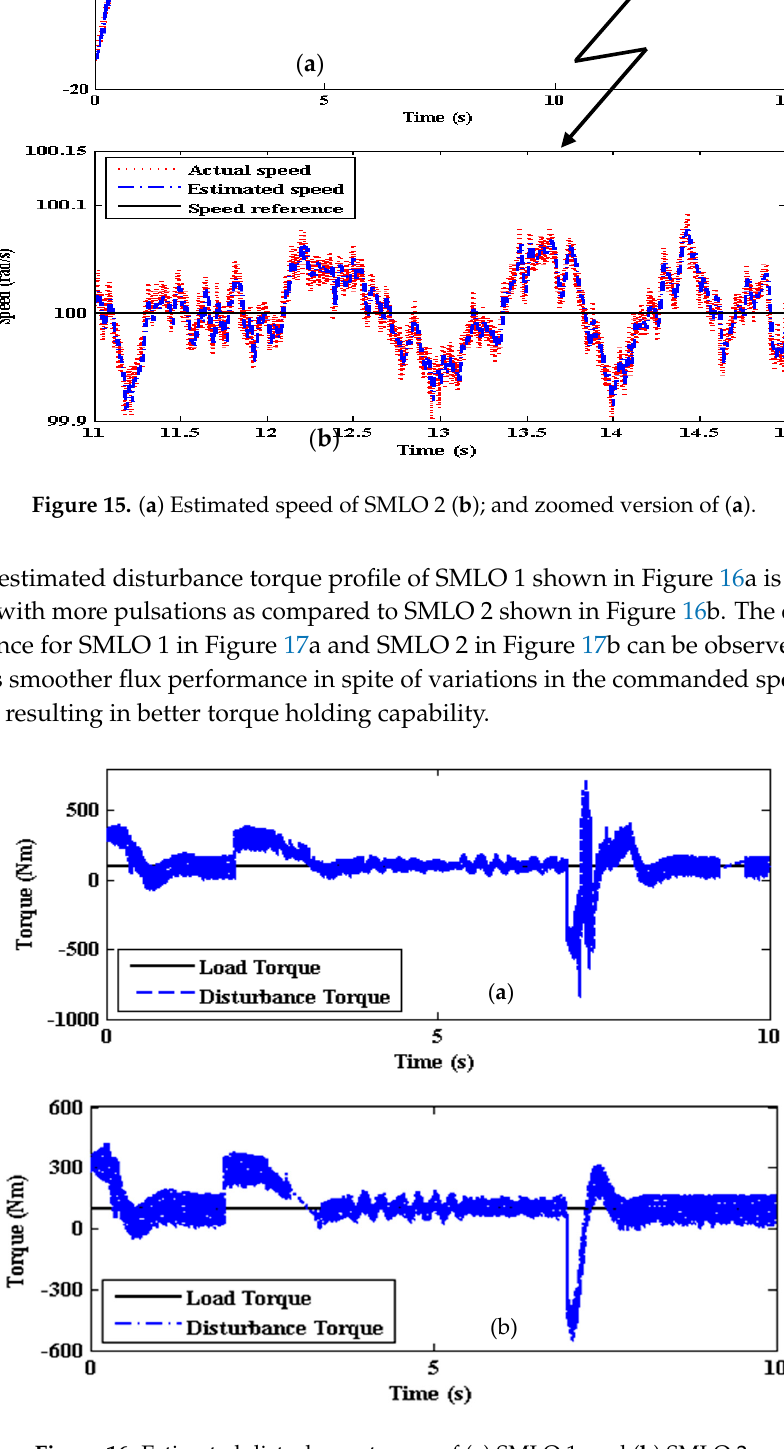
Figure 14. ( a ) Estimated speed of SMLO 1; and ( b ) zoomed version of ( a ).